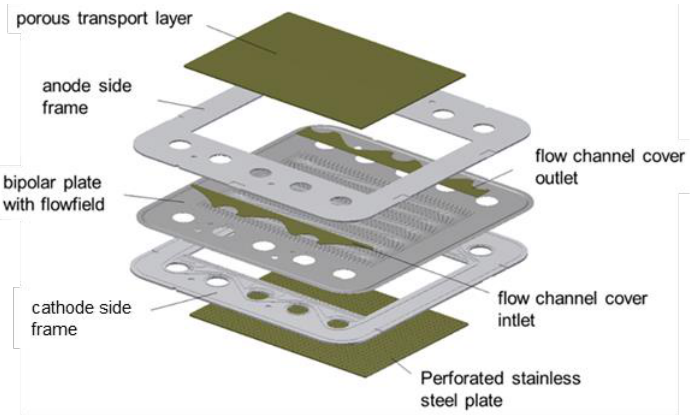
Figure 7. Bipolar unit consisting of several parts from the Ekolyser project.